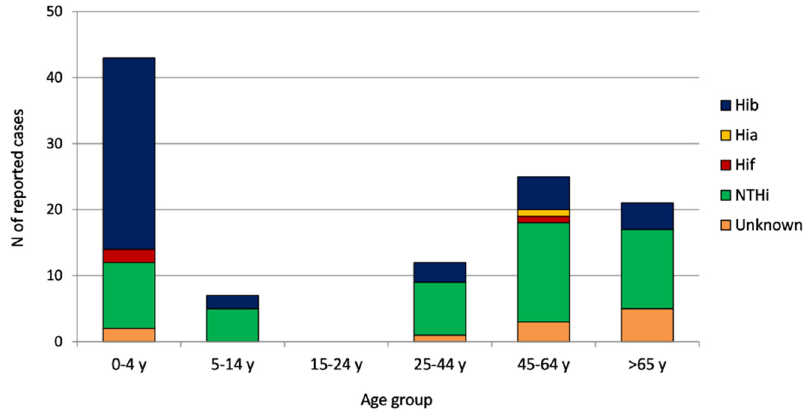
Figure 2. Serotype distribution of meningitis cases due to H. influenzae by age group. Figure 2. S erotype distribution of meningitis cases due to H. influenzae by age group.